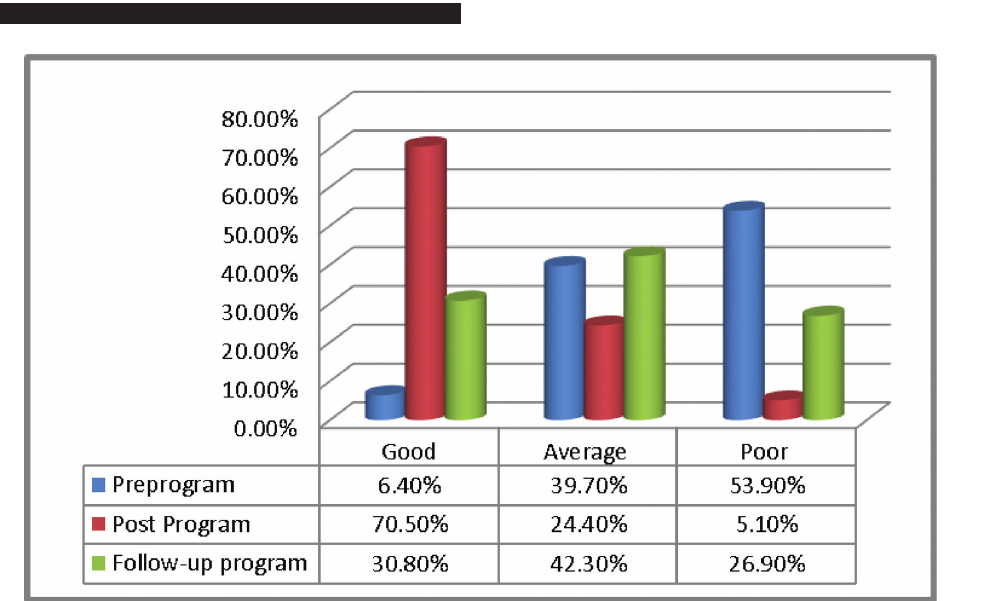
Figure 1. Frequency Distribution of Total Scores of Reported Caregivers’ Knowledge about Pressure Ulcer Prevention throughout the Training Program ( n = 78).